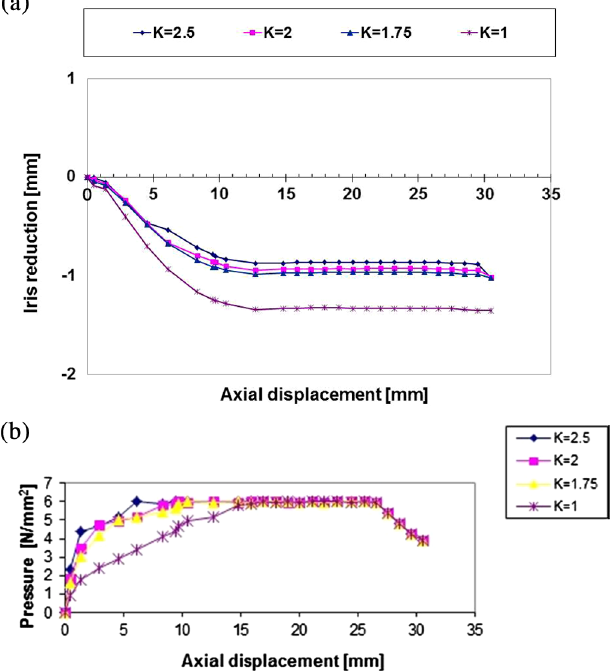
FIG. 6. (a) and (b) FEM simulations of the iris reduction vs axial displacement (upper image) and of internal pressure vs axial displacement (lower